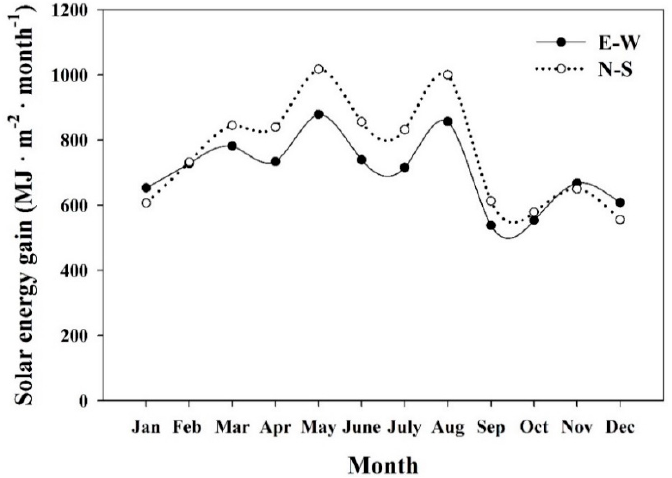
Figure 12. Monthly total solar energy gain for greenhouse oriented ( a ) E ‐ W and ( b ) N ‐ S.